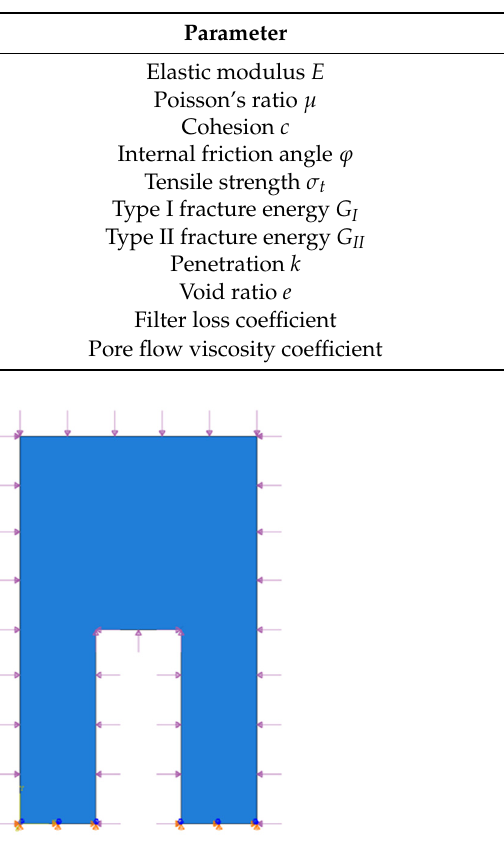
Table 1. Model Mechanical Parameters.